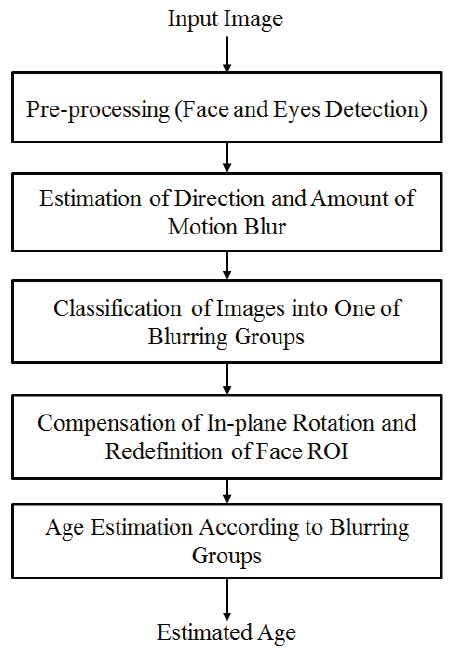
Figure 1. Overall procedure for our